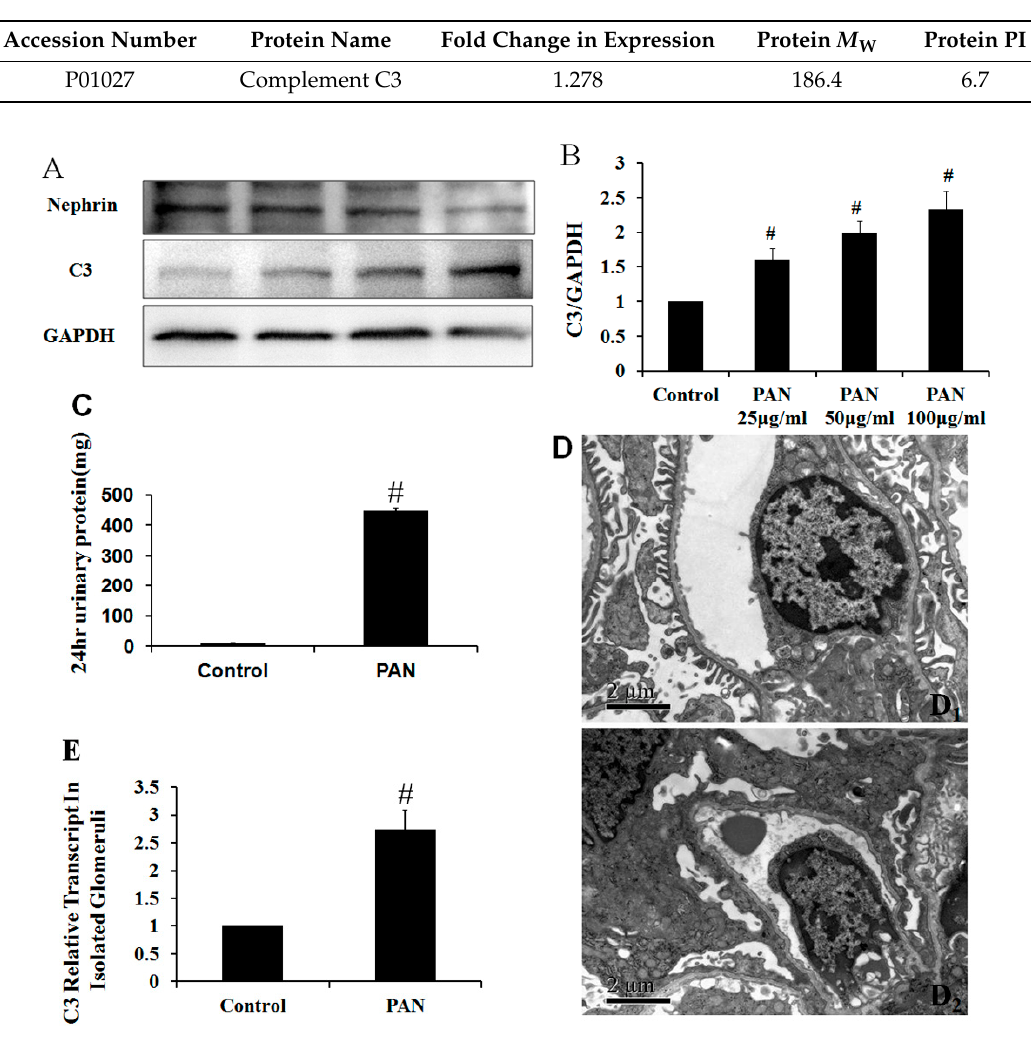
Figure 3. C3 expression increased in podocytes after PAN treatment for 24 h and in